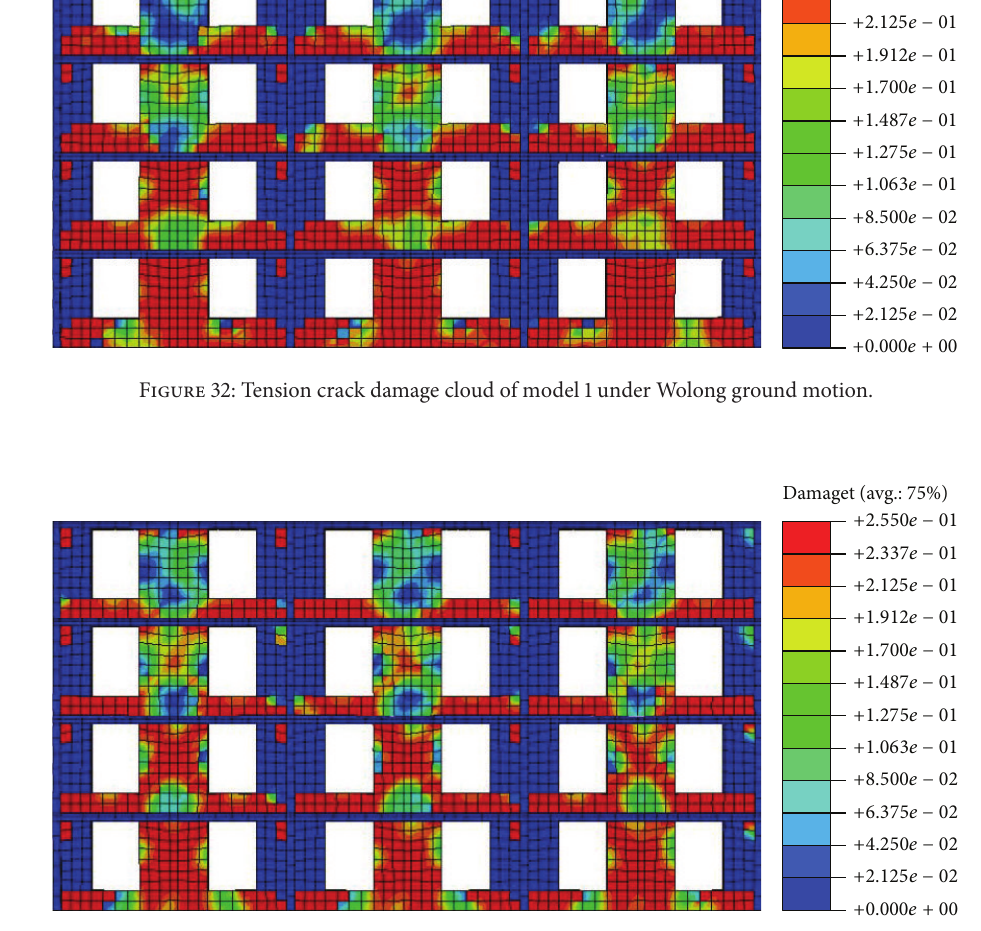
Figure 33: Tension crack damage cloud of model 5 under Wolong ground motion.